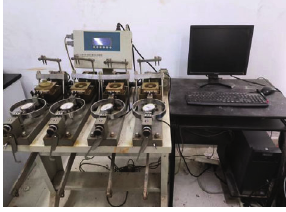
Figure 2: Microcomputer-controlled direct shear